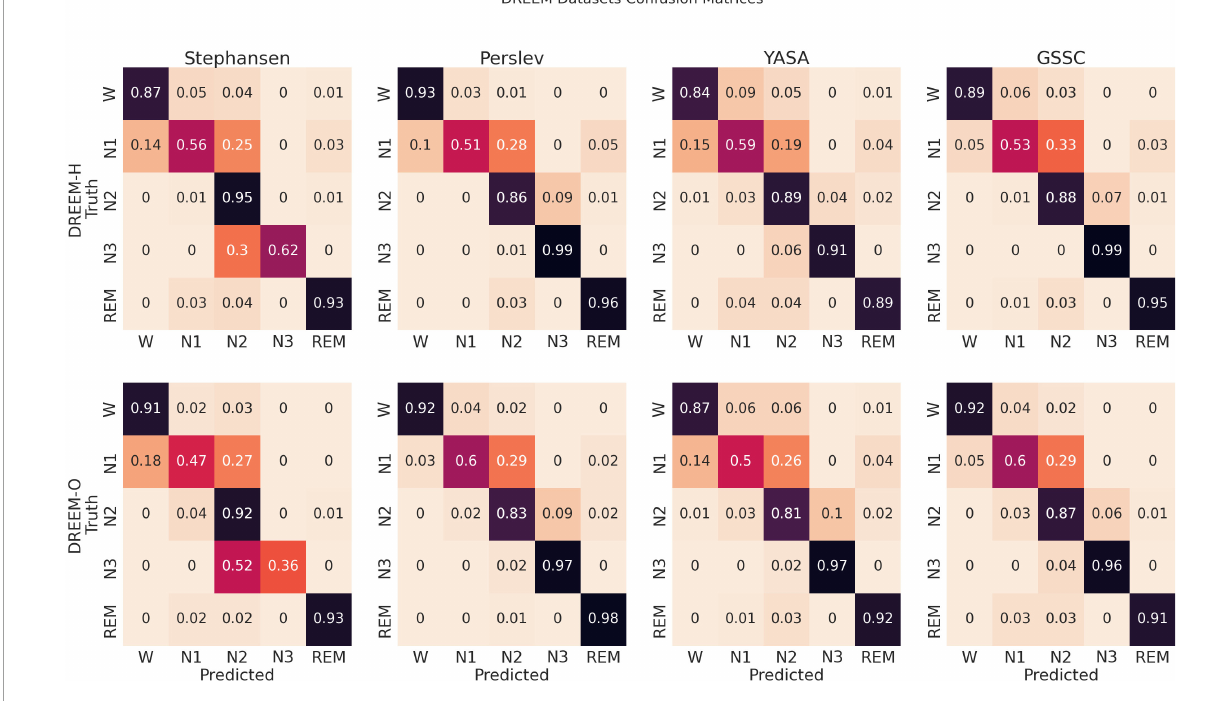
FIGURE4 Confusion matrices. These row-normalized confusion matrices show the inferential behavior for four, recently developed, high performance classifiers, including the Greifswald Sleep Stage Classifier (GSSC). The diagonal indicates the accuracy, and off-diagonal elements show how the true sleep states tended to be misclassified. The first row shows results for the DREEM Healthy dataset ( n = 25), and the second for the DREEM Obstructed dataset ( n =